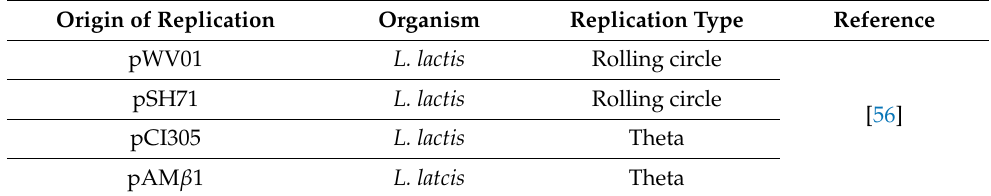
Table 1. Replicons used for the construction of vectors for